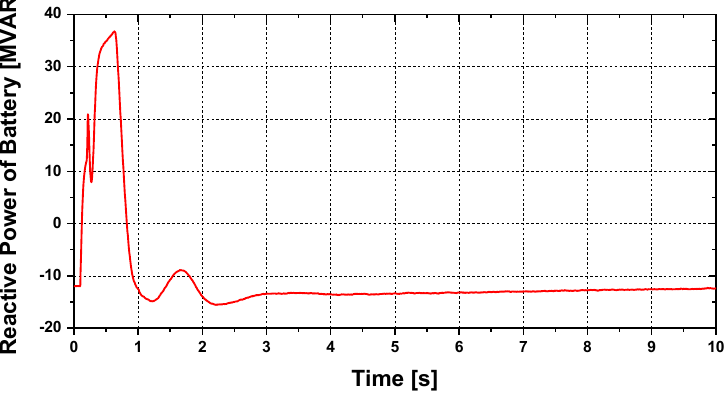
Figure 11. Reactive power response of BSS (Case 2).